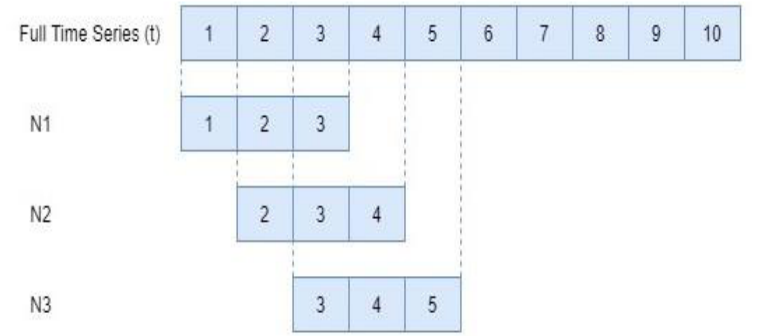
Figure 1. Illustration of the rolling window mechanism.